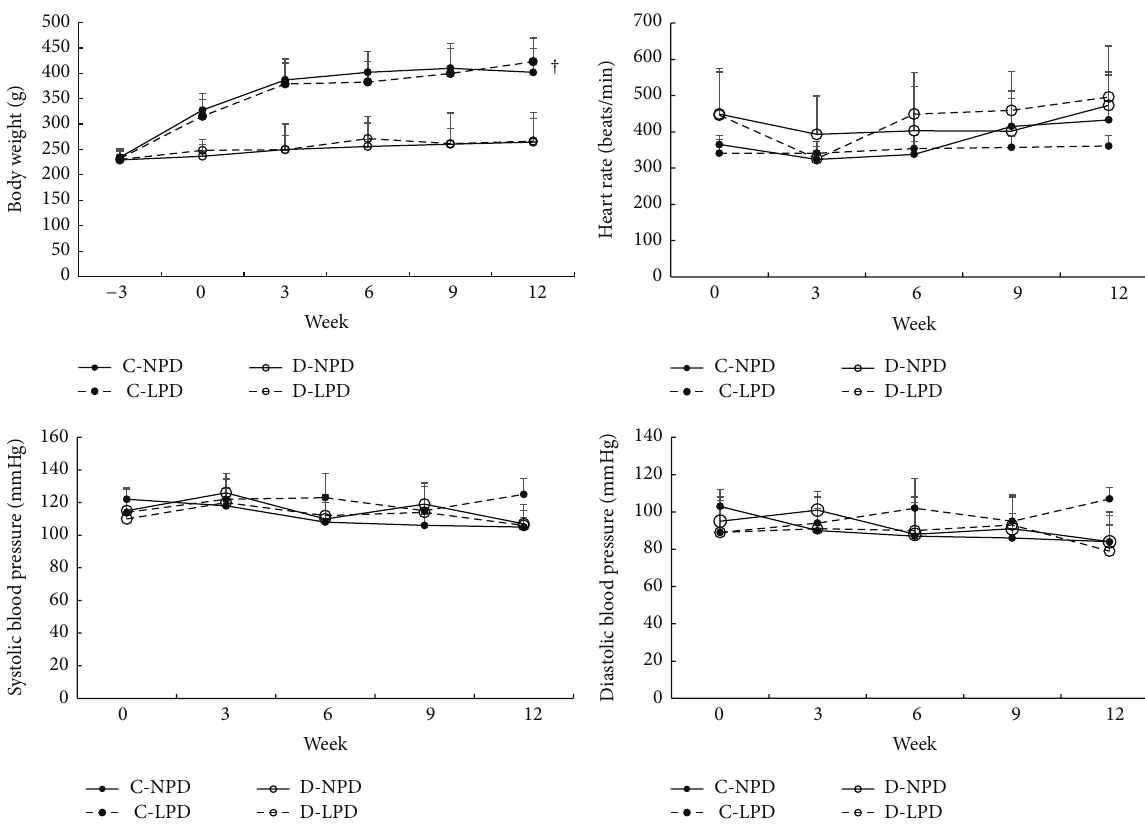
Figure 2: Time course of main vital signs among different rat groups. Heart rate, systolic blood pressure, and diastolic blood pressure were recorded by an indirect tail-cuff method. Solid circle with solid and dashed lines represents C-NPD and C-LPD group, respectively, while hollow circle with solid and dashed lines shows data of D-NPD and D-LPD group, respectively. Data were expressed as mean ± SD. † 𝑃 < 0.05 for D-LPD versus C-NPD rats in the global trend